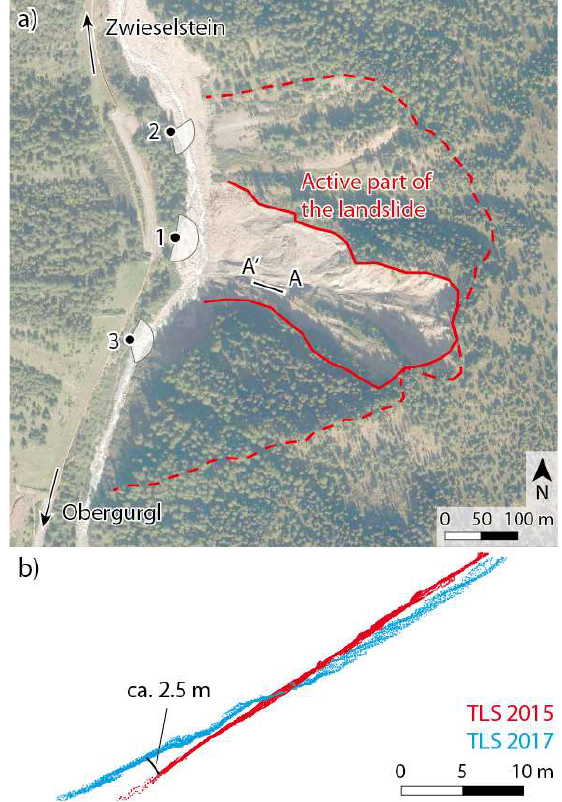
Figure 5. Location and TLS setup of the landslide site (a) and Profile A-A’ (b) showing changes between the data acquisitions 2.5.3